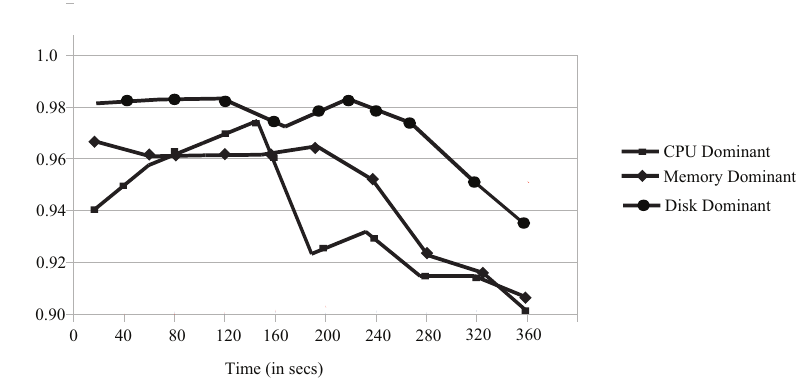
Figure 8. Individual resource utilization over a period of one hour.